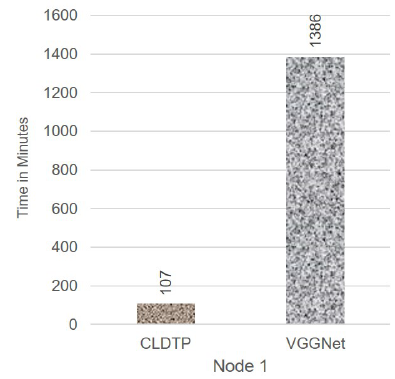
Figure 14. Time required for feature extraction using CLDTP and VGGNet on STAD.